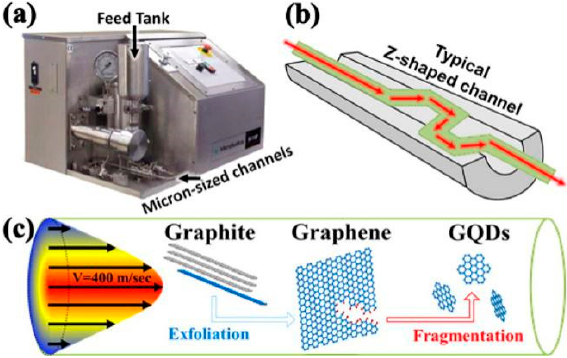
Figure 9. ( a ) Photograph of typical microfluidizer. The graphite aqueous suspension is powered by 30 kpsi pump from the feed tank through microsized channels. Schematics of ( b ) Z-shaped channels with diameters ranging from 400 μ m down to 87 μ m, and ( c ) typical flow profile within the channel with maximal flow speed of 400 m s − 1 . The graphite flakes are exfoliated into graphene sheets and further fragmented into nanosized GQDs. Reproduced from [67]. Copyright American Chemical Society, 2016.